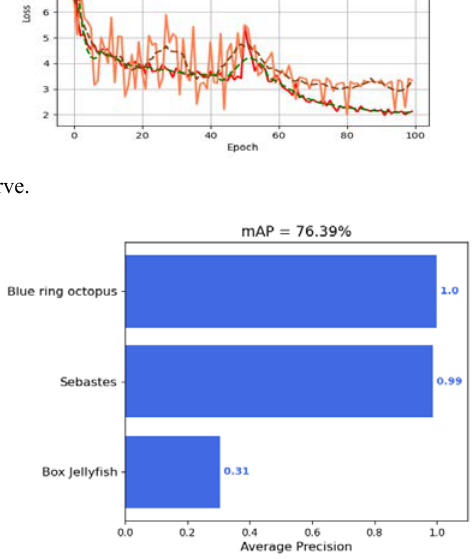
Fig. 4. Mean accuracy of the YOLOX